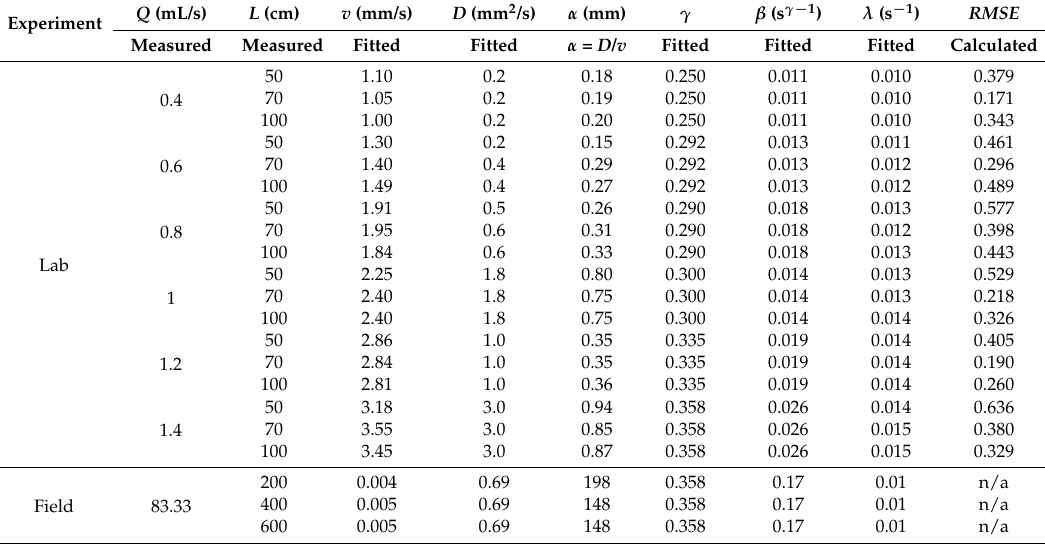
Table 6. The best-fit parameters for the tempered time fractional advection–dispersion equation (tt-fADE) model (10) and (11) at different flow rates and travel distances. In the legend, α is the dispersivity; γ is the time/scale index; β is the fractional-order capacity coefficient; and λ is the truncation